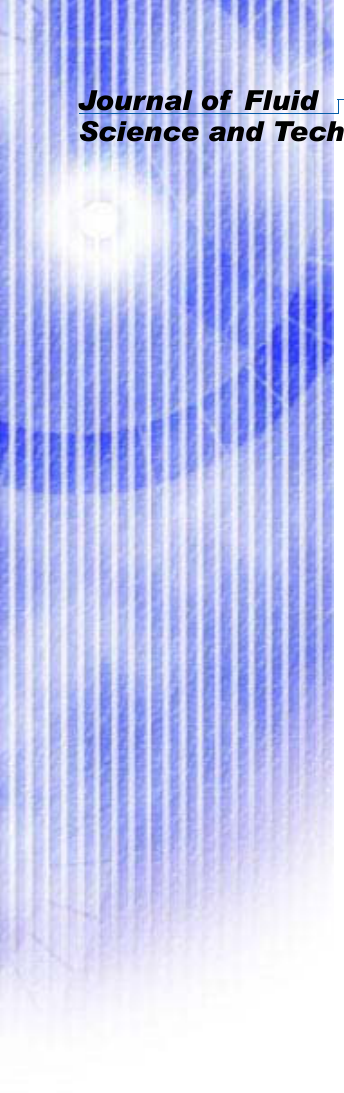
=0.41 µm; (b) S3, R q